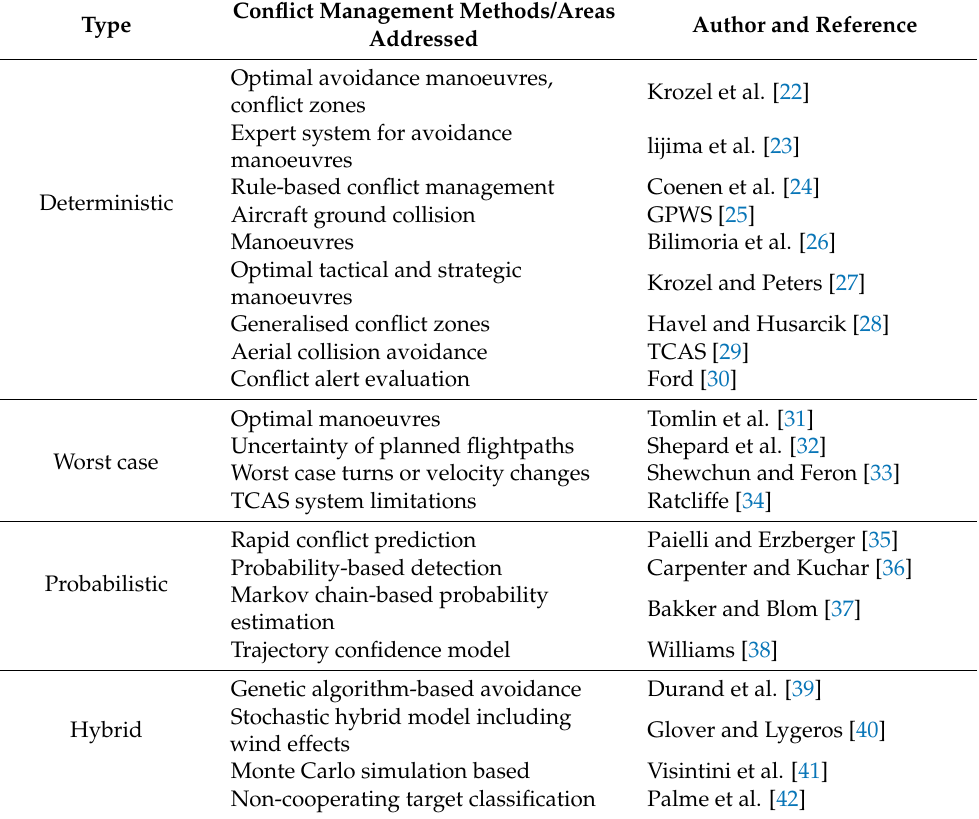
Table 1. Conflict management methods